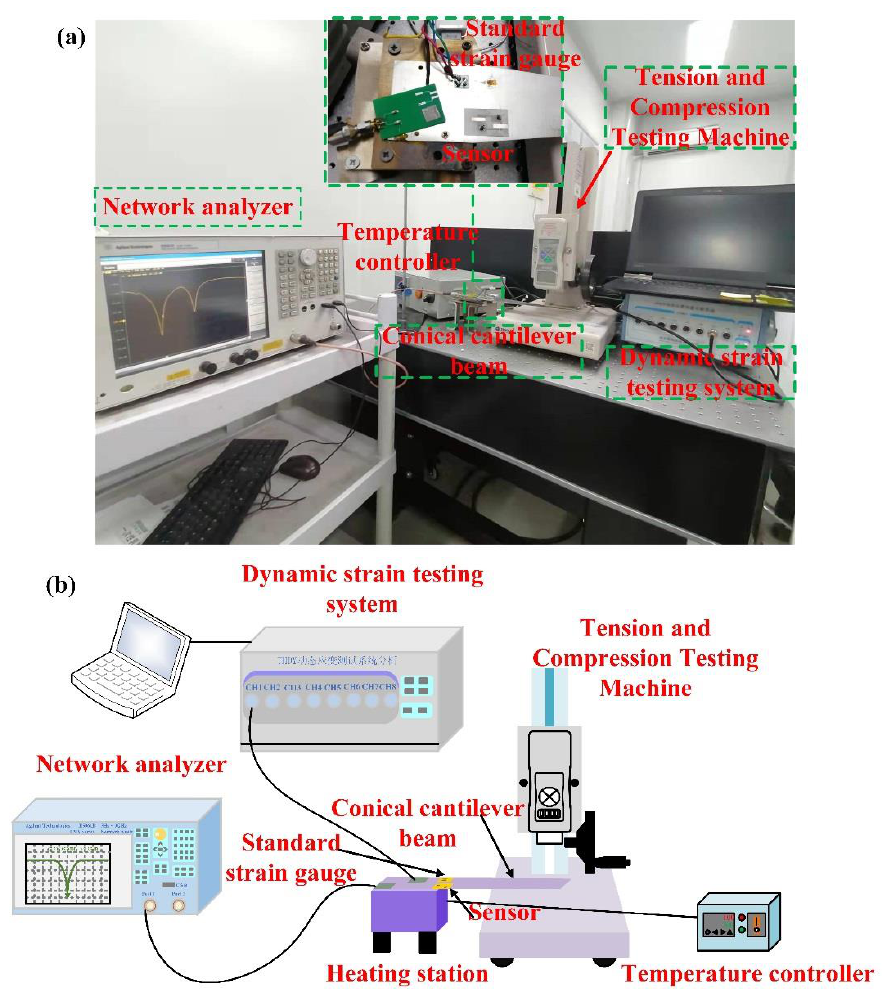
Figure 4. ( a ) The measurement platform for the measurement of temperature – strain parameters. ( b ) Schematic diagram of temperature – strain mixing test